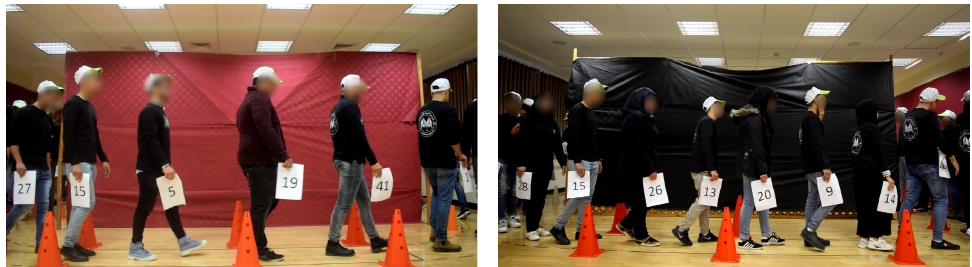
Figure 1. Snapshots from Palestine experiments. ( Left ): UM experiment, N = 20. ( Right ): UX experiment, N =